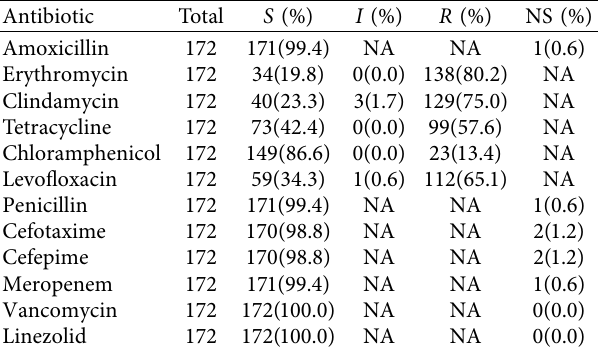
Table 3: Antibiotic susceptibility profiles of 172 GBS isolates from pregnant